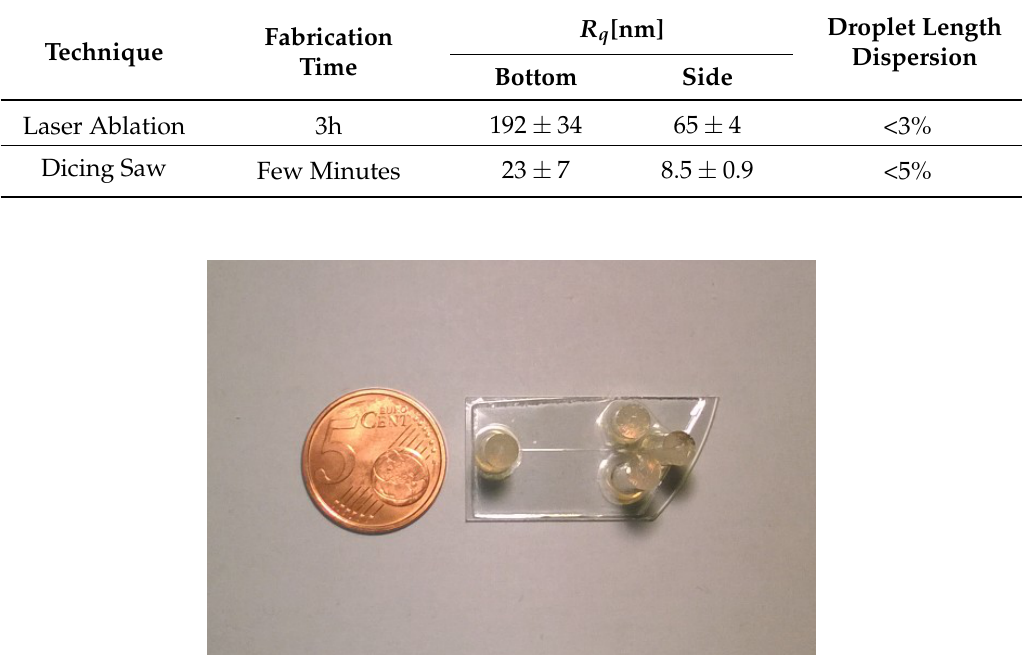
Figure 11. Photo of one of the tested microfluidic devices whose channels were realised by means of the dicing